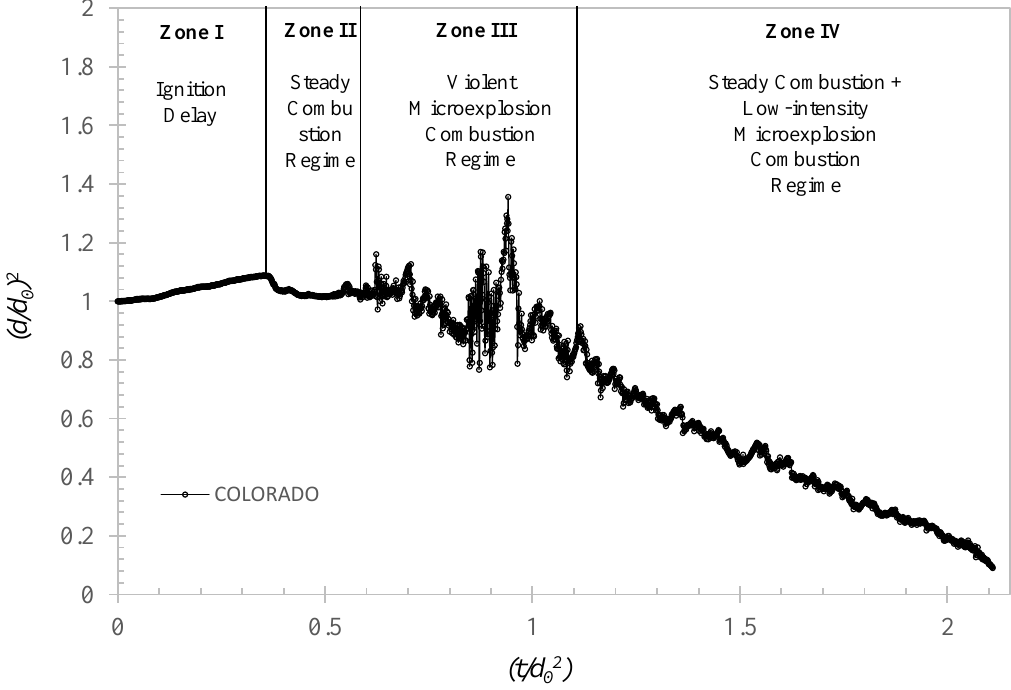
Figure 4. The evolution of ( d / d 0 ) 2 with time for Colorado crude oil with various combustion zones ( d 0 = 0.855 mm ).